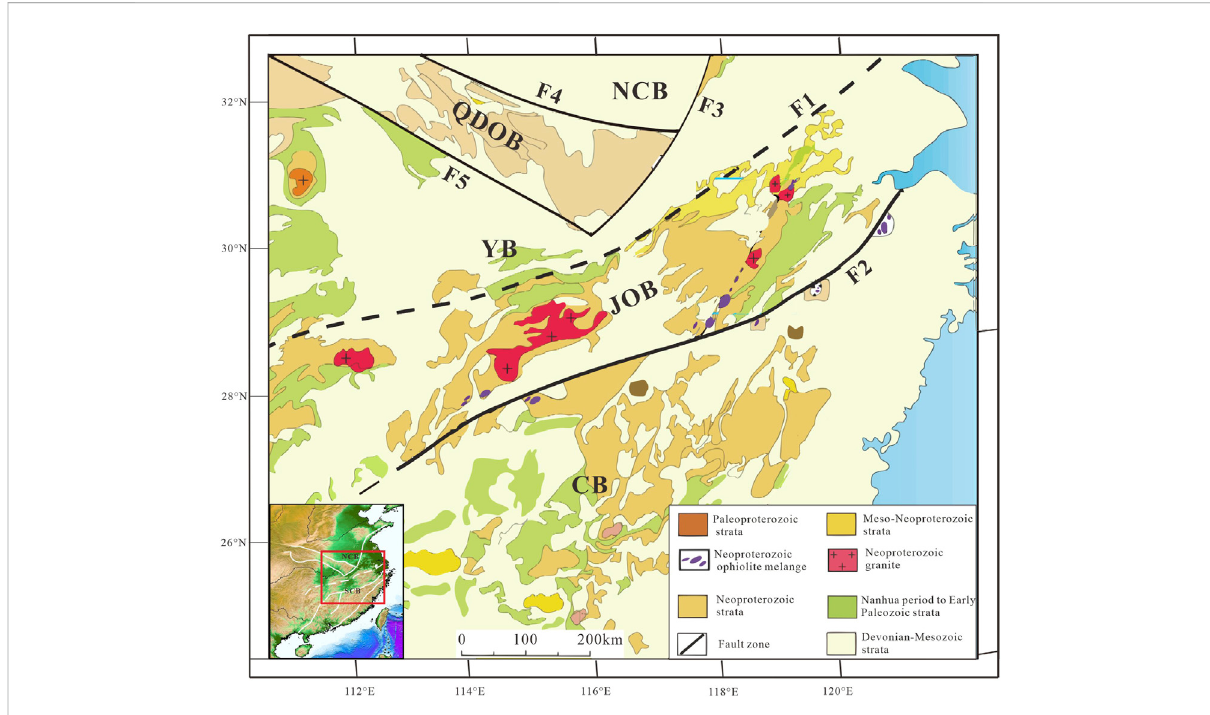
FIGURE 1 Simpli fi edgeologicalmapofsoutheasternChina,modi fi edfromShuetal.(2019).NCB,NorthChinaBlock;SCB,SouthChinaBlock;YB,Yangtze Block; JOB, Jiangnan Orogenic Belt; QDOB, Qinling – Dabie Orogenic Belt; CB, Cathaysia Block; F1, Jiujiang – Shitai buried fault; F2, Jiangshan – Shaoxing fault; F3, Tanlu fault; F4, Xinyang – Shucheng fault; F5, Xiangfan – Guangji fault. The red rectangle in the illustration at the lower left corner indicates the study